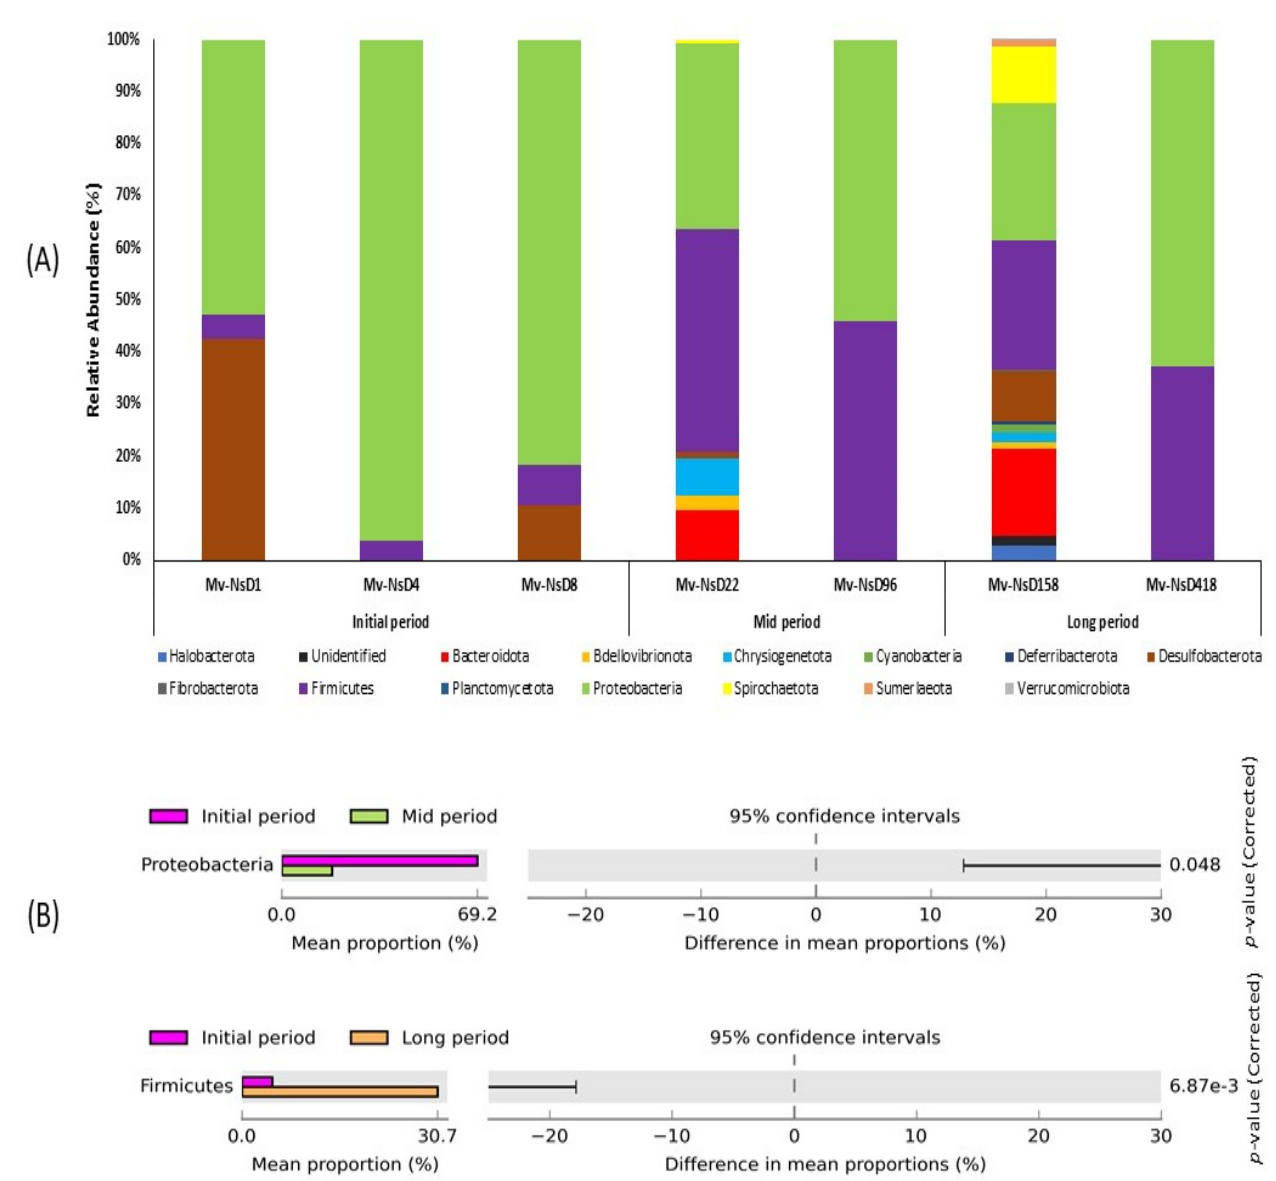
Figure 3. Relative abundance of bacterial diversity at ( A ) the phylum level, showing a comparison between the samples collected at the initial, mid, and long periods after the volcanic eruption. Stacked bar graphs illustrate the abundance of phyla associated with each of the samples. The numbers of abundant phyla in the mid and long periods were higher than in the initial-period samples. ( B ) Post hoc plot of the statistically significant enriched bacterial phyla of the samples collected at various time intervals. The figures show the abundance of the enriched bacterial phylum in the left-side panel, the mean proportion (%) of the enriched bacterial phylum in middle, and the significant difference ( p < 0.05) in the right-side panel.